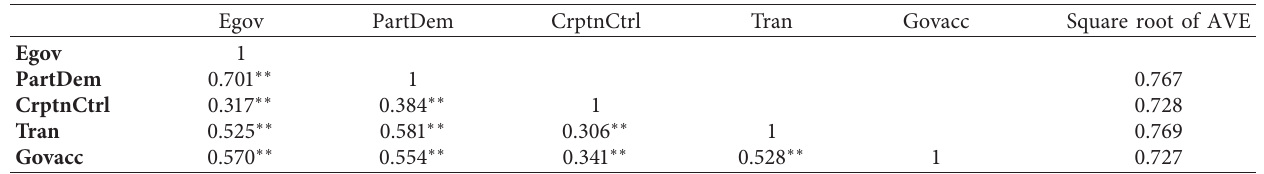
Table 5: Correlation matrix and square root of